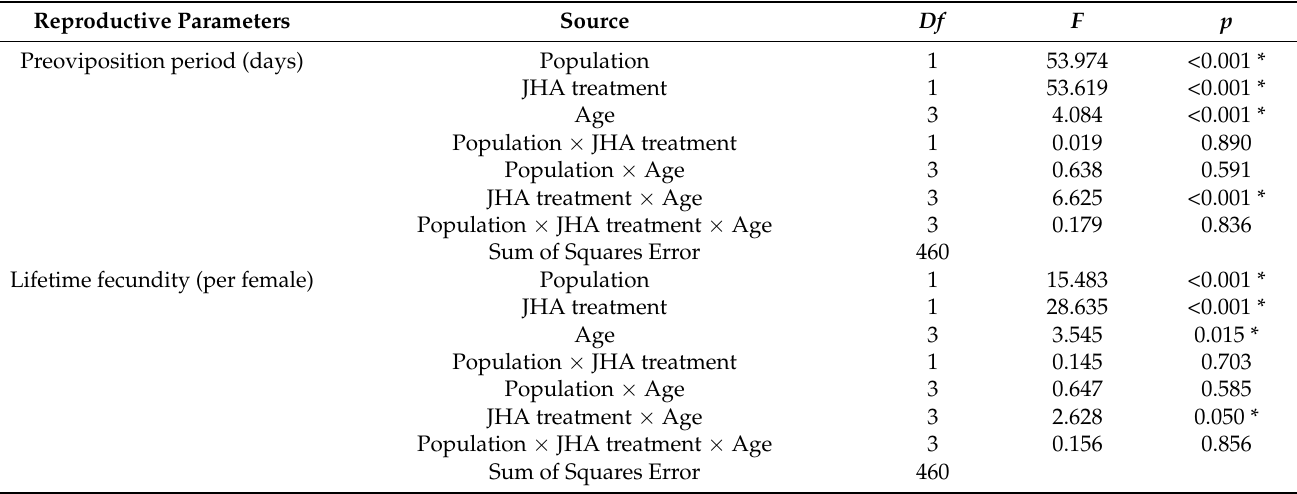
Table 1. Summary of three-way ANOVA analysis on the effects of population, JHA treatment and age (days after emergence) on reproductive performances of Mythimna separata